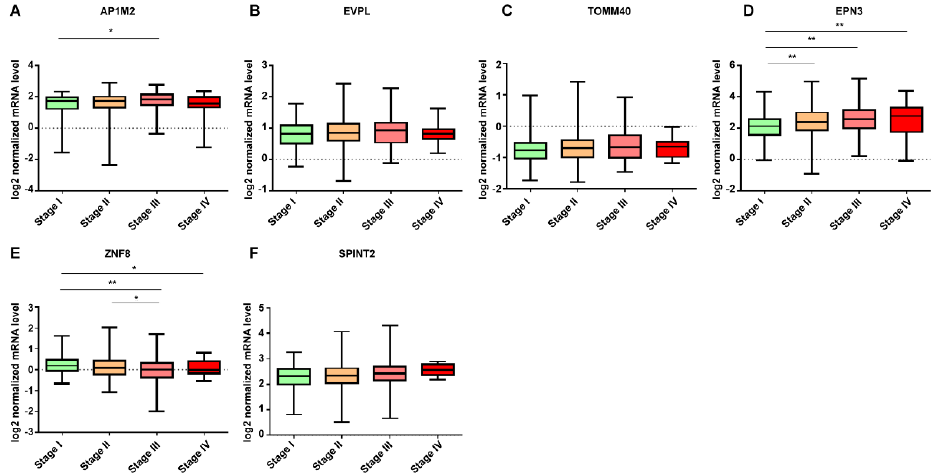
Figure 6. Expression patterns of DE mRNAs upregulated in breast cancer tissue according to tumor stages. ( A ) AP1M2, ( B ) EVPL, ( C ) TOMM40, ( D ) EPN3, ( E ) ZNF8, and ( F ) SPINT2. Data are reported as mean ± SD. * p < 0.05, ** p < 0.01.